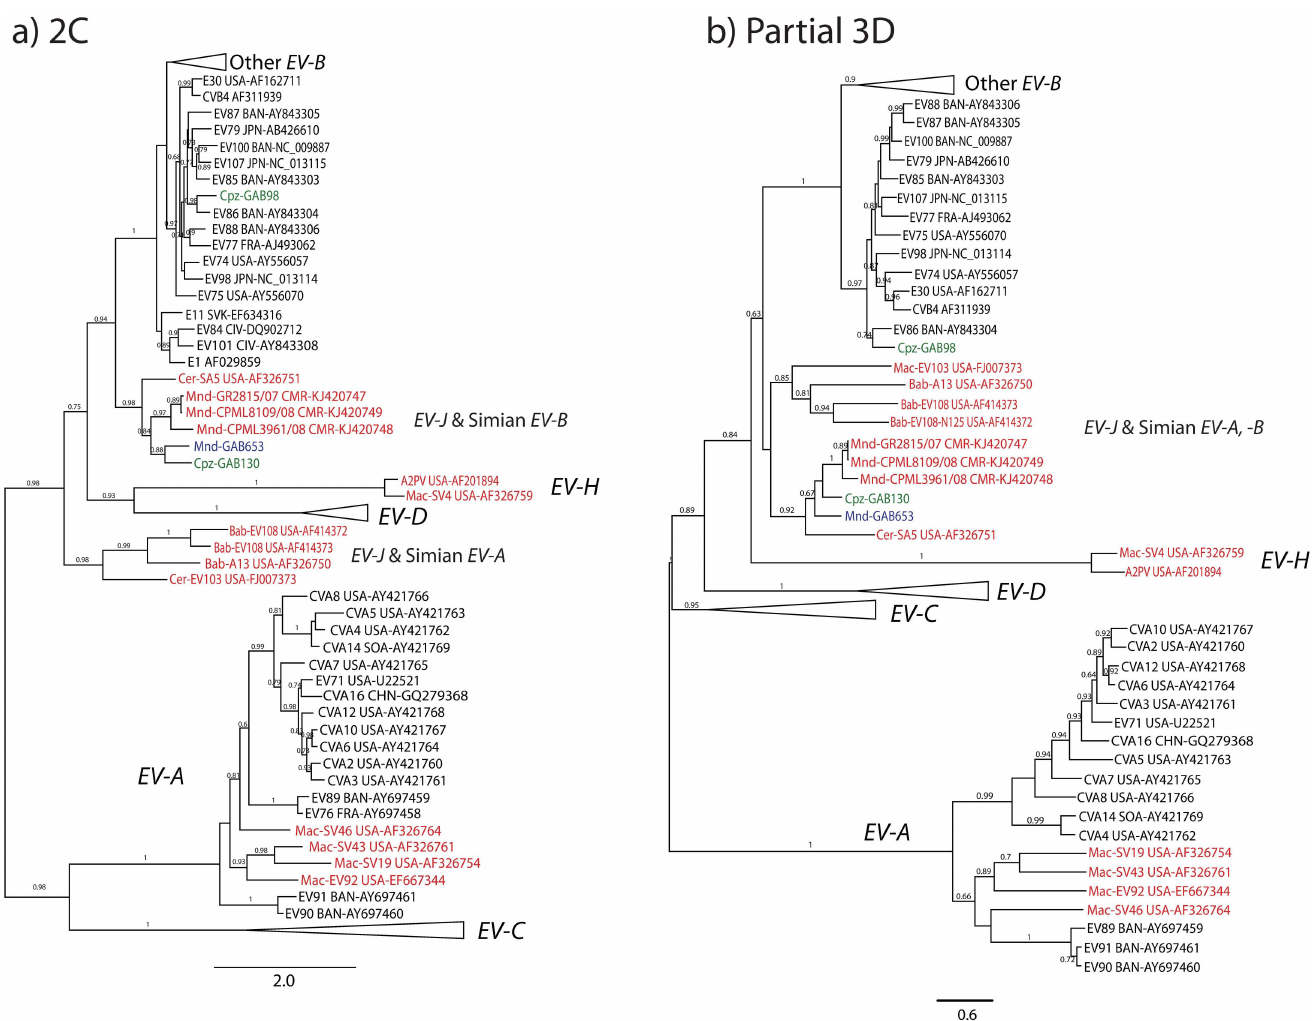
Fig 5. Phylogeneticrelationshipof humanand NHP EV-B based on the complete2C gene (a) and 935 nucleotides of the 3D region, from position5,979 to 6,914 of the PV1 Mahoneystrain (GenBank #V01149)(b). Designations are identicalto Fig 2.